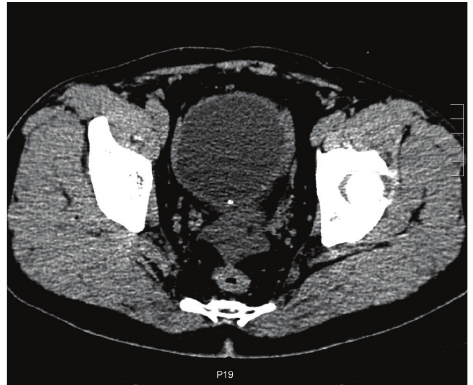
Figure 2: Axial CT shows cystic wall with punctate calcification in the distal portion.